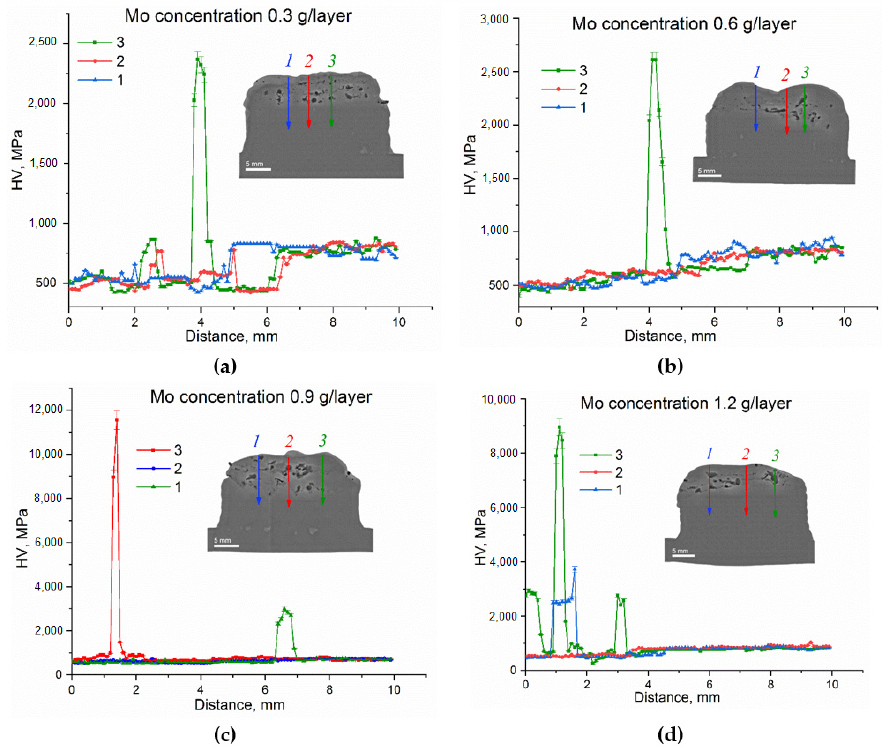
Figure 13. Microhardness profiles obtained along the lines shown in the insets 0.3 g/layer Mo ( a ), 0.6 g/layer Mo ( b ), 0.9 g/layer Mo ( c ) and 1.2 g/layer Mo ( d ).